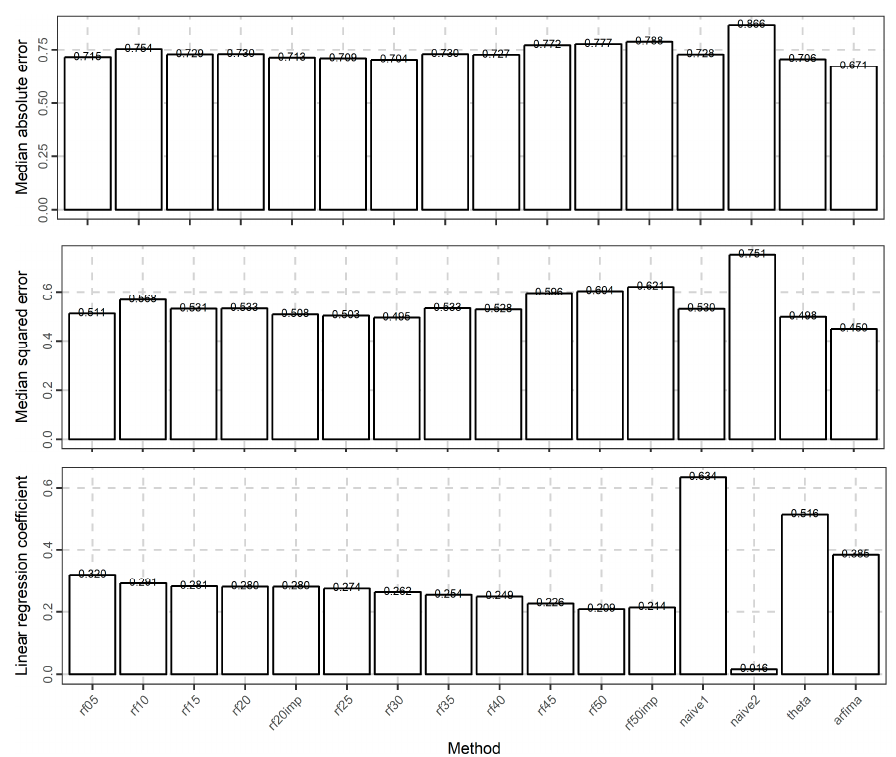
Figure 3. Barplots of the medians of the absolute errors, medians of the squared errors and regression coefficients when forecasting the 101st value of 1000 simulated time series from an ARMA(1, 0) model with φ 1 = 0.6.